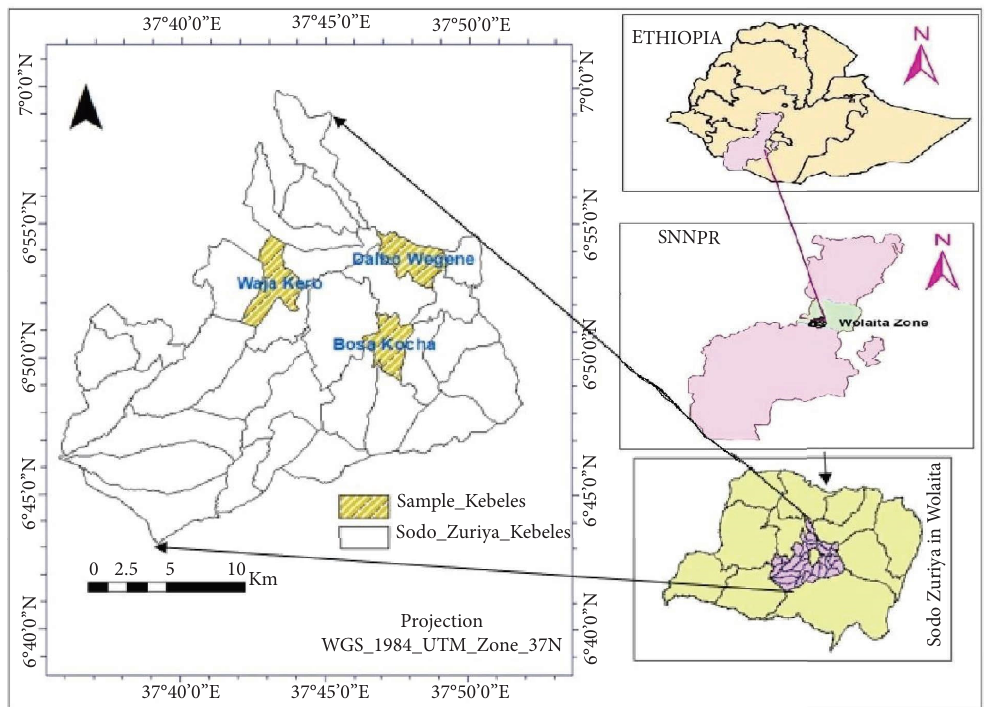
Figure 2: Map of the Sodo Zuria district showing the location of the study areas.